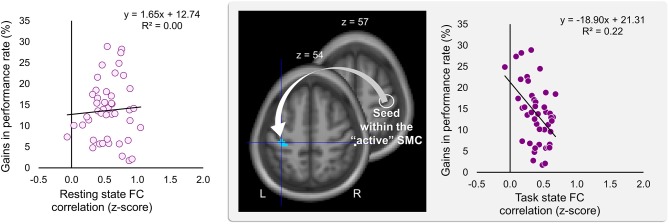
Inverse relationship between individual differences in performance gains and task-based FC strength between the two somatomotor cortices. Gains in performance rate during the training were negatively correlated with the degree of the task-based functional connectivity (FC) between the two somatomotor cortices (SMC). The whole-brain FC analysis was performed on the task state time-series using the ROI within the “active” SMC as a seed (the white circle); individual gains in performance rate were entered as a covariate of interest (middle panel). These gains were calculated as a percentage change in mean performance duration during the last six vs. the first six blocks of training—higher values indicating greater improvement. Gains in performance rate are plotted against FC values extracted from the resting and task state time-series (left and right plot, respectively). The FC values were calculated between the ROI within the “active” SMC and the peak voxel of the significant cluster within the left somatomotor hand area (xyz = −36, −27, 54) (the white arrow). The cyan blob resulted from the statistical maps thresholded at p < 0.005 (two-tailed). L and R—left and right hemisphere, respectively.